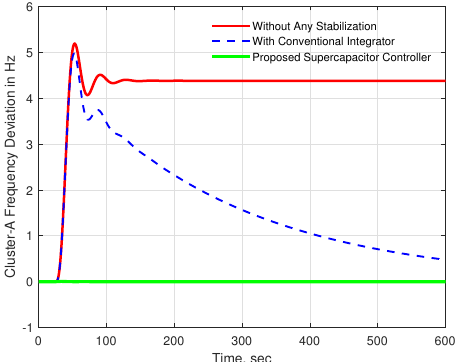
Figure 14. Frequency response for cluster A 0.15 p.u. disturbance in cluster B.